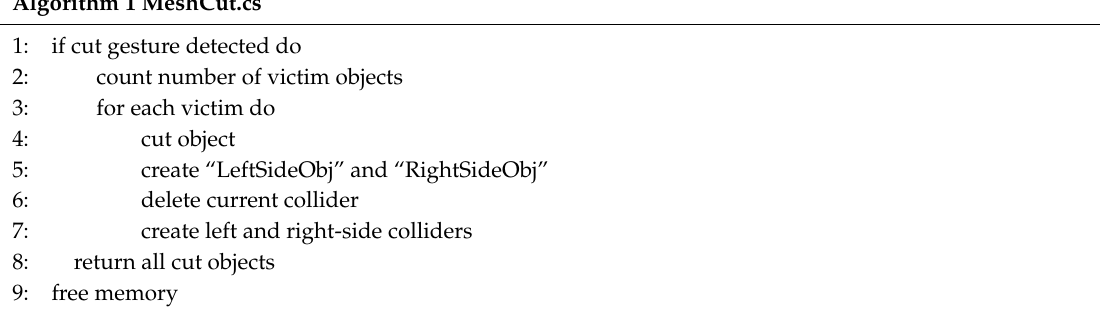
Algorithm 1 MeshCut.cs